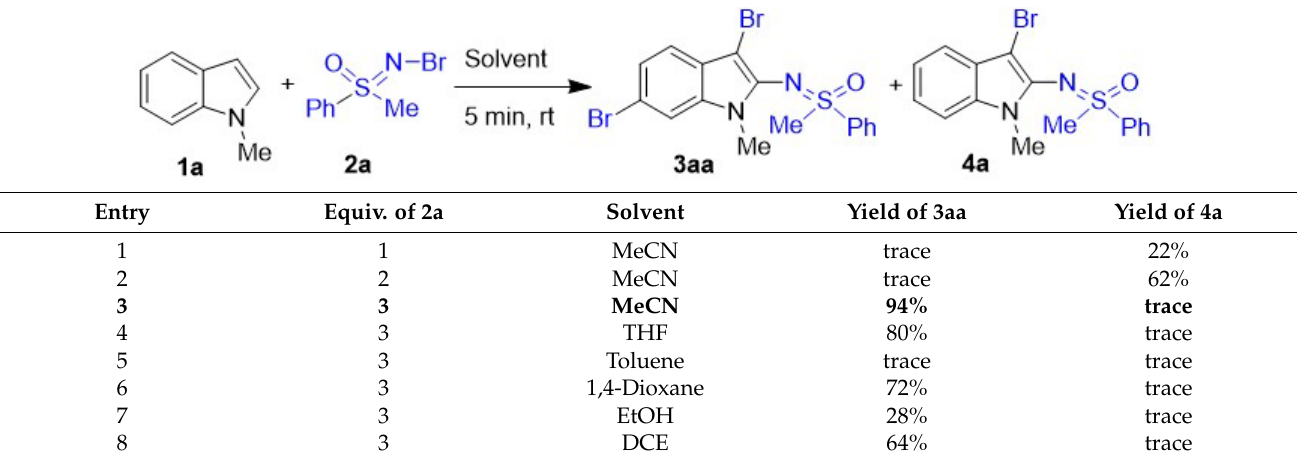
Table 1. Exploring experimental conditions.